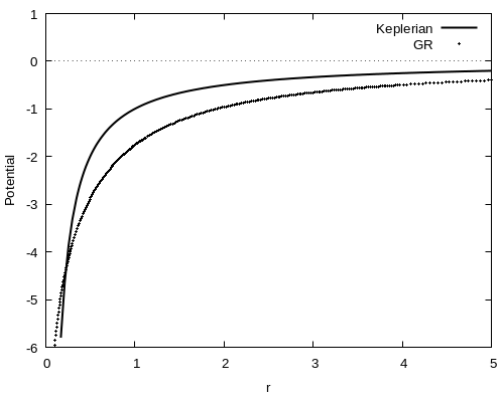
Figure 5. Comparison between the Keplerian disk and the GR disk potentials used in the calculation of Φ cg at the disk equator, in units of M , for α =